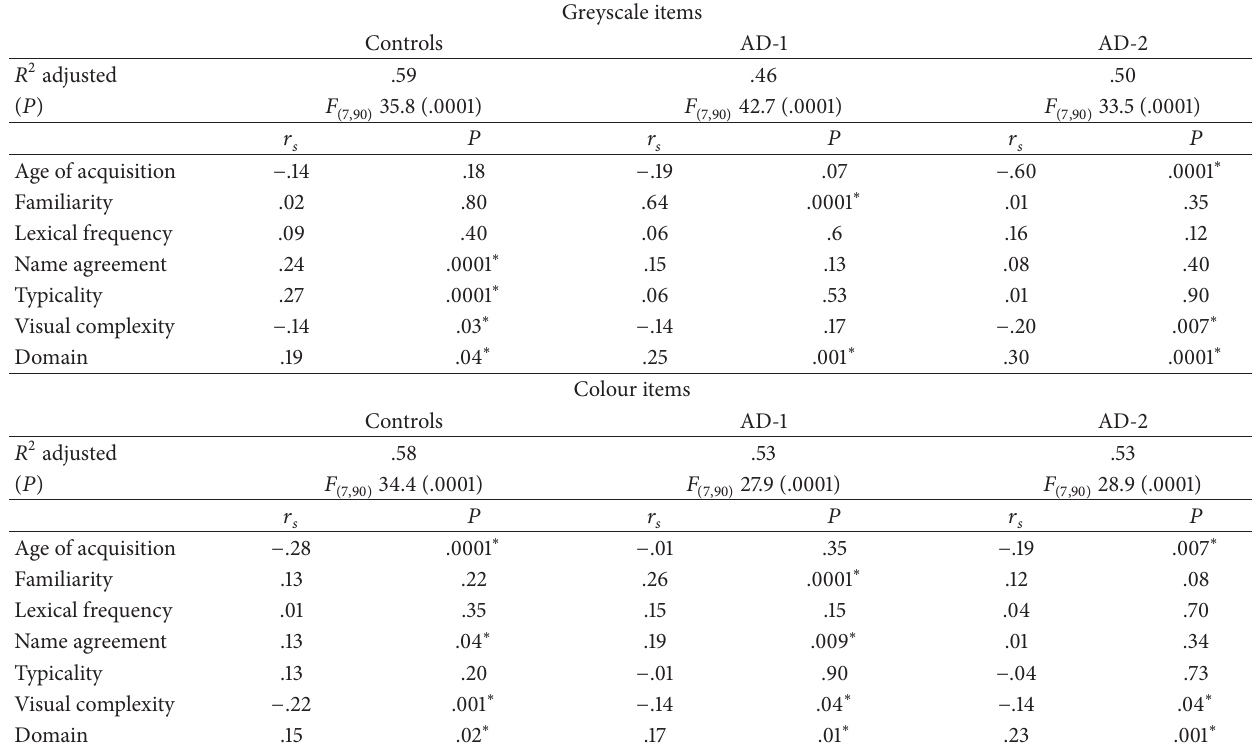
Table 4: Independent predictors of naming performance, greyscale and colour items, in stepwise multiple regressions for controls (NC) and AD patients (two time-points); 𝑟 𝑠 = semipartial correlation